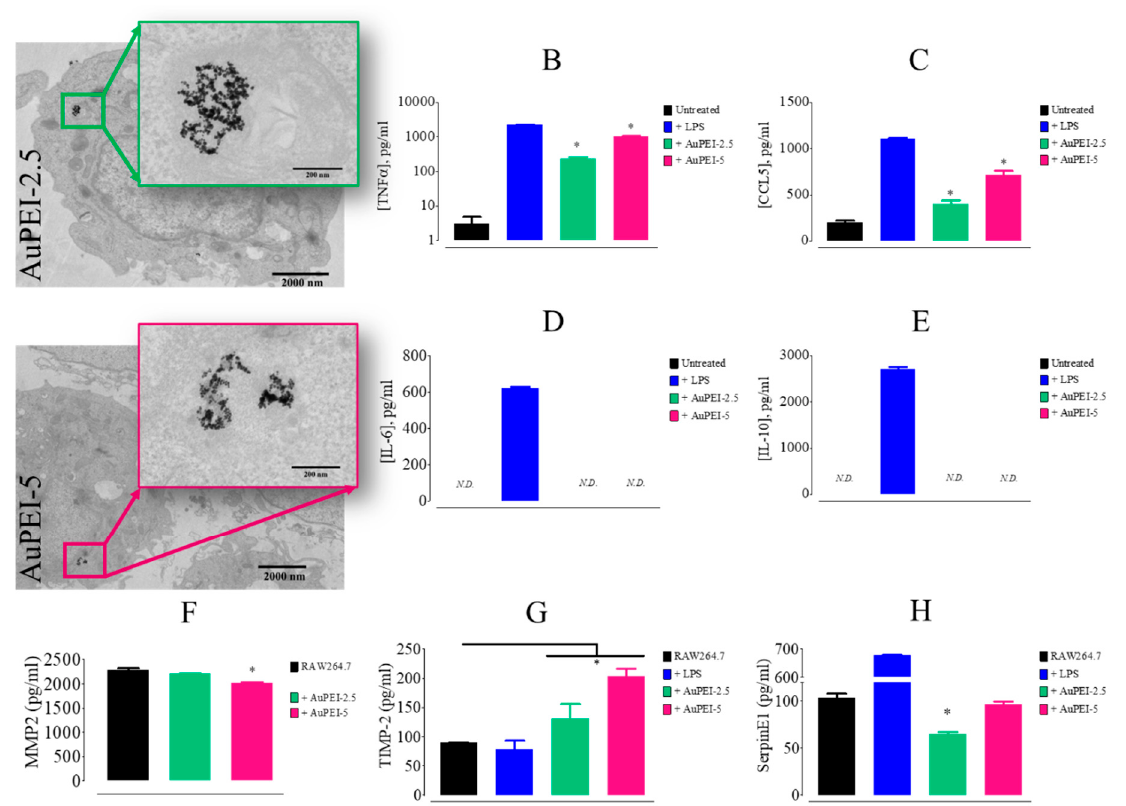
Figure 2. AuPEI nanocomposite effects on murine macrophage activation status. ( A ) TEM imaging of RAW264.7 cells incubated with 5 µg/mL AuPEI nanocomposites for 24 h. Supernatant level of secreted ( B ) TNF α , ( C ) CCL5, ( D ) IL-10, ( E ) IL-6, ( F ) MMP2, ( G ) TIMP-2, and ( H ) SerpinE1. (n = 6; * p < 0.05 Mann–Whitney test, 95% confidence).